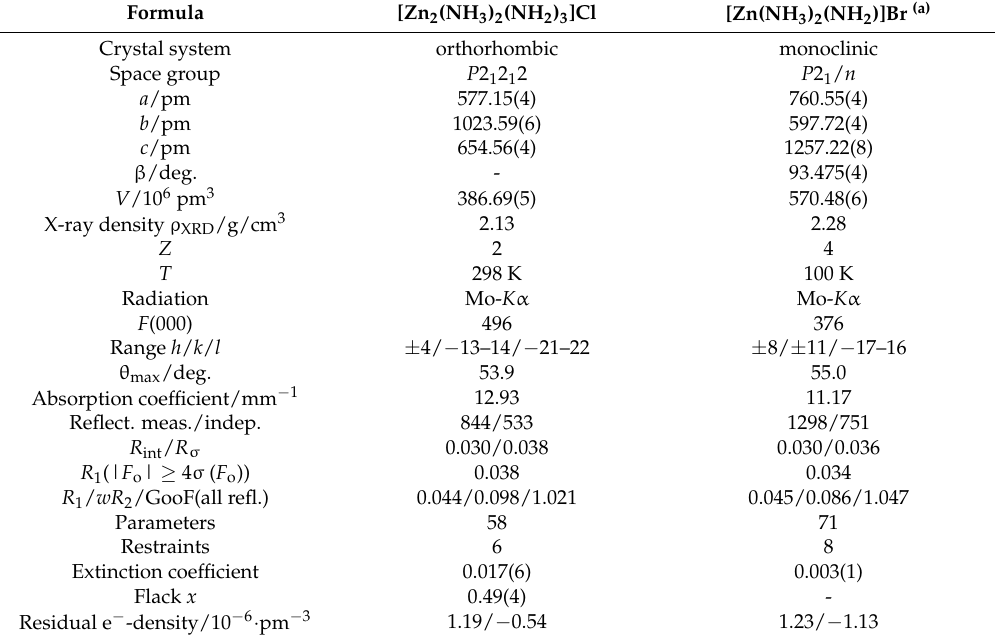
Table 1. Selected crystallographic data and information for the structure determination of